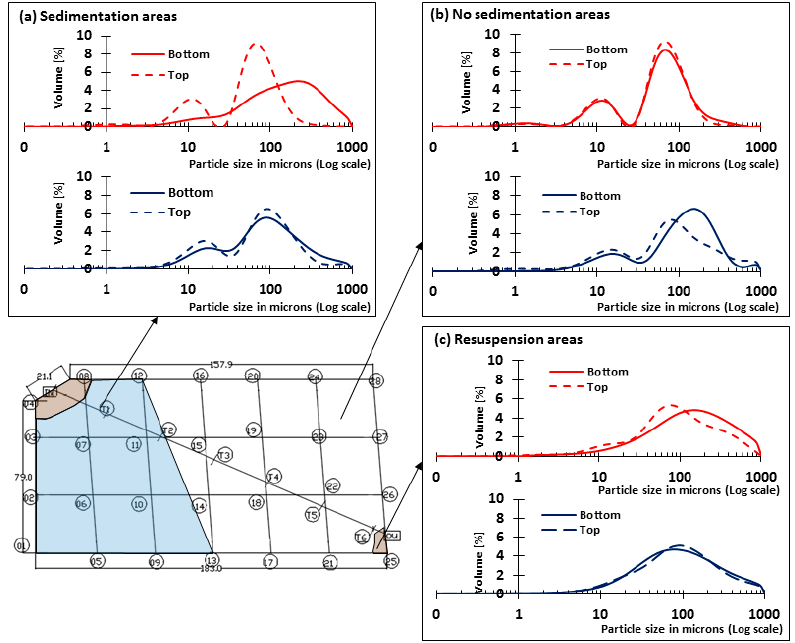
Figure 4. Comparison of PSD at the top and bottom of the pond for dry season(red) and wet season (blue) ( a ) Sedimentation areas; ( b ) Non-sedimentation areas; ( c ) Resuspension areas.